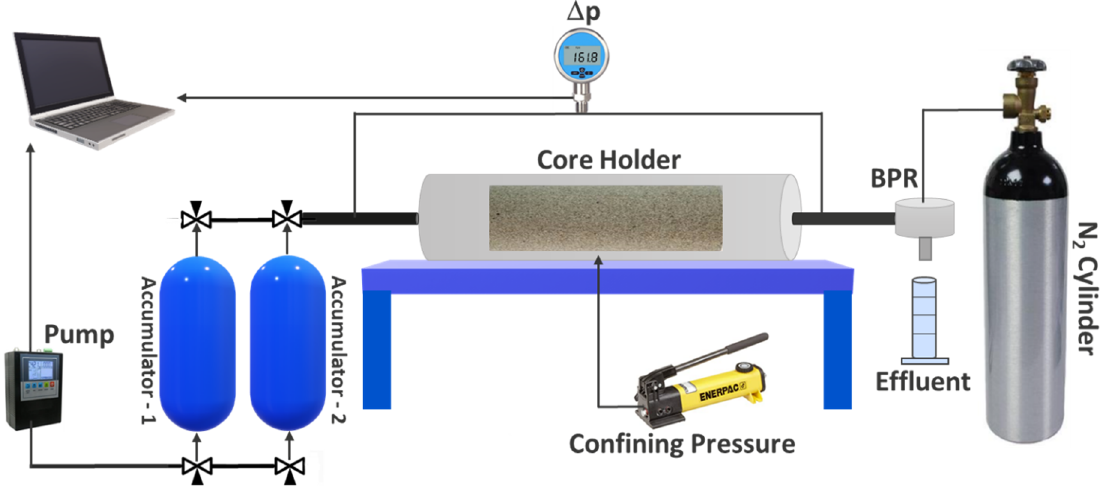
Figure 2. Schematic of coreflood apparatus used for oil displacement tests.